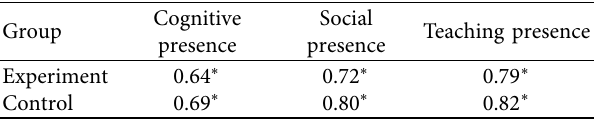
Table 3: The interrater reliability between codifiers by presence types.